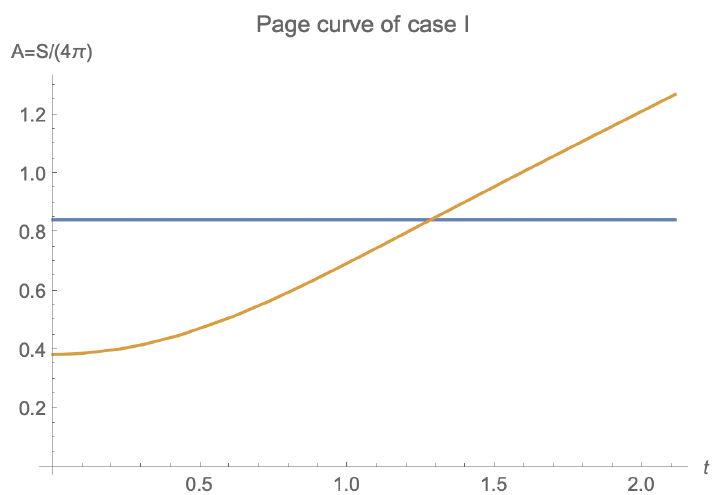
Figure 11 . Page curve of case I for d = 4 and V = 1 . The orange and blue lines denote the RT surface in the no-island and island phases, respectively. The Page curve is given by the orange line before Page time, and is given by the blue after Page time. The entanglement entropy firstly increases with time (orange line) and then becomes a constant (blue line), which recovers the Page curve of eternal black